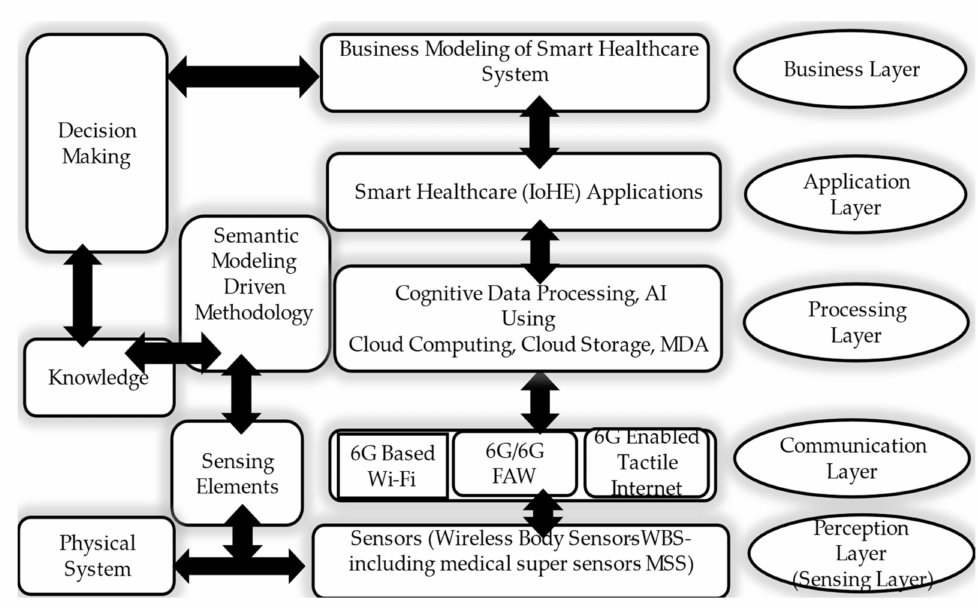
Figure 14. The 6GCIoHE system